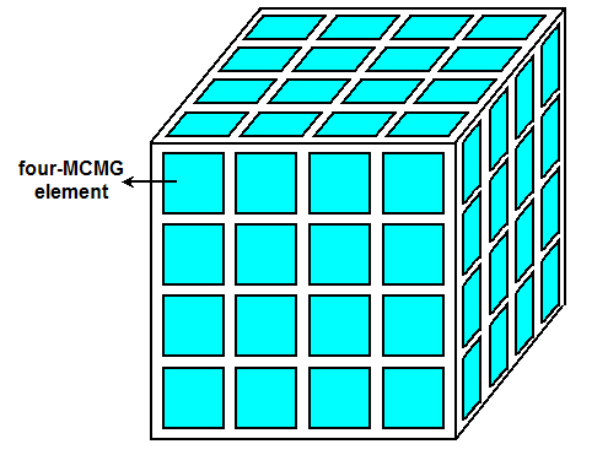
Figure 11. The array configuration of MCMG elements on a